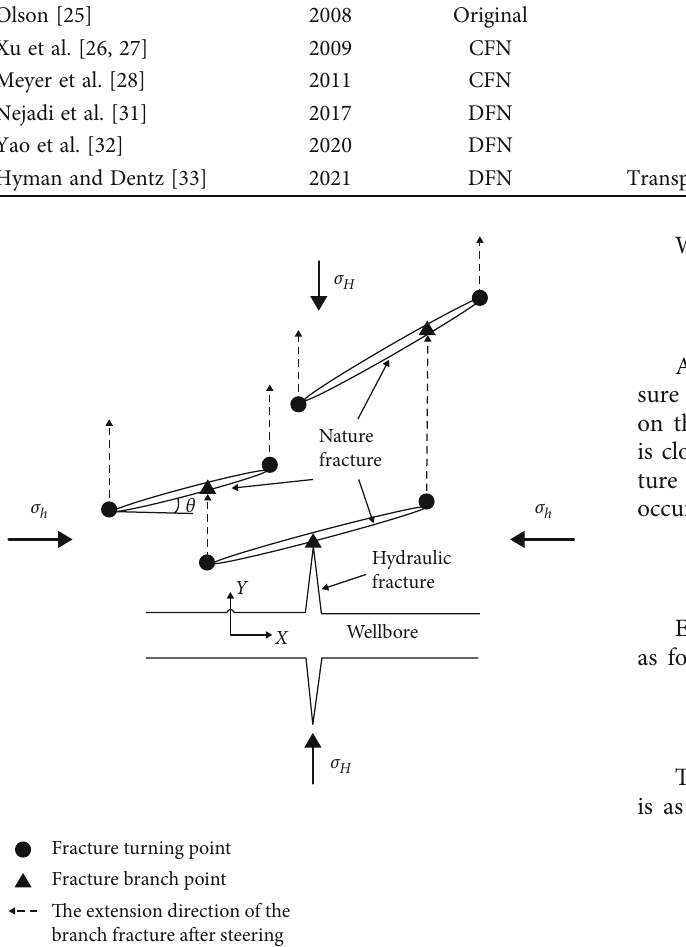
Figure 1: Schematic diagram of the formation of a fracture